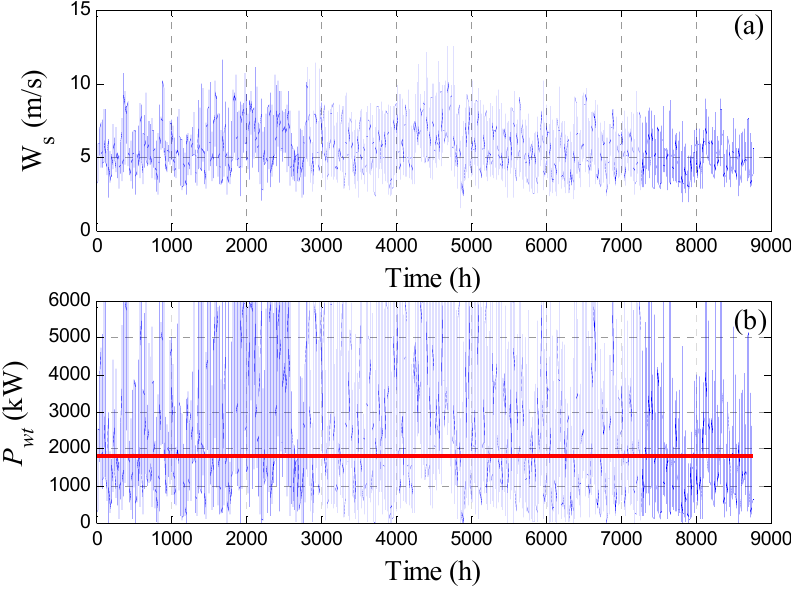
Figure 3. Annual wind property profile for the site: ( a ) wind speed; ( b ) generated power; constant line denotes the target value; solid line: required power load.